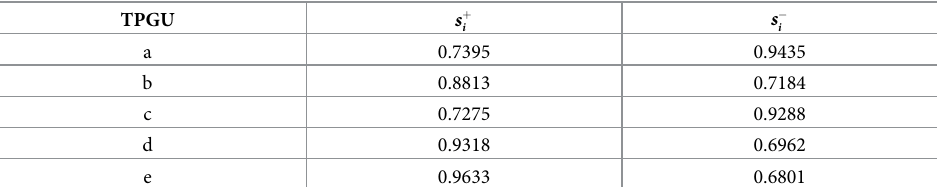
Table 5. Grey correlation degree.